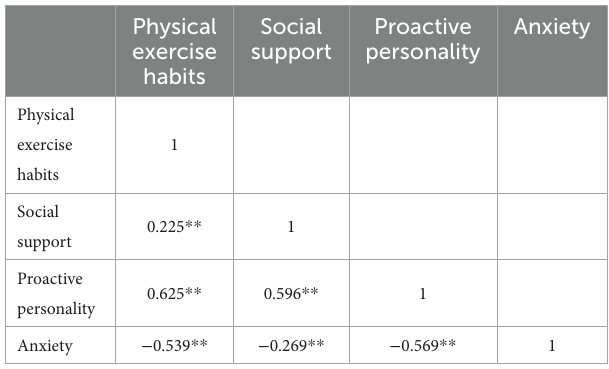
TABLE 4 Correlation test results of physical exercise habits, anxiety, social support, and proactive personality.